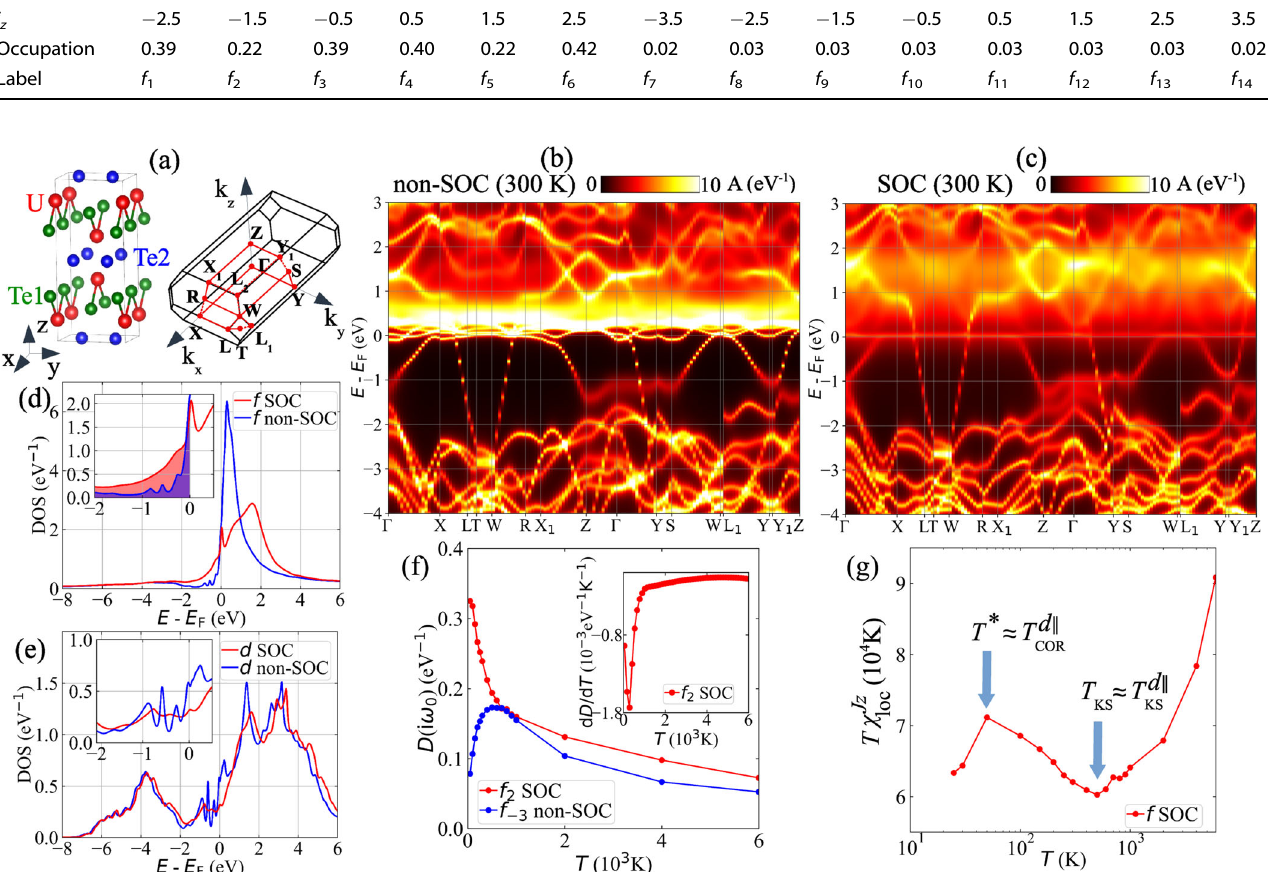
Fig. 2 Calculated electronic structure of UTe 2 . a Crystal structure and fi rst Brillouin zone of UTe 2 . b and c Calculated spectral function without and with inclusion of SOC at 300 K. d and e U-5 f and U-6 d projected DOSs with and without inclusion of SOC at 300 K. Insets show magni fi ed views near the Fermi level. f f 2 and f − 3 projected DOSs at the Fermi level for SOC and non-SOC, respectively. Inset shows temperature derivation of f 2 DOS. g T χ J Z for U-5 f with inclusion of SOC. The blue arrows point local minimum and maxima at which scales of loc Kondo effect were evaluated.